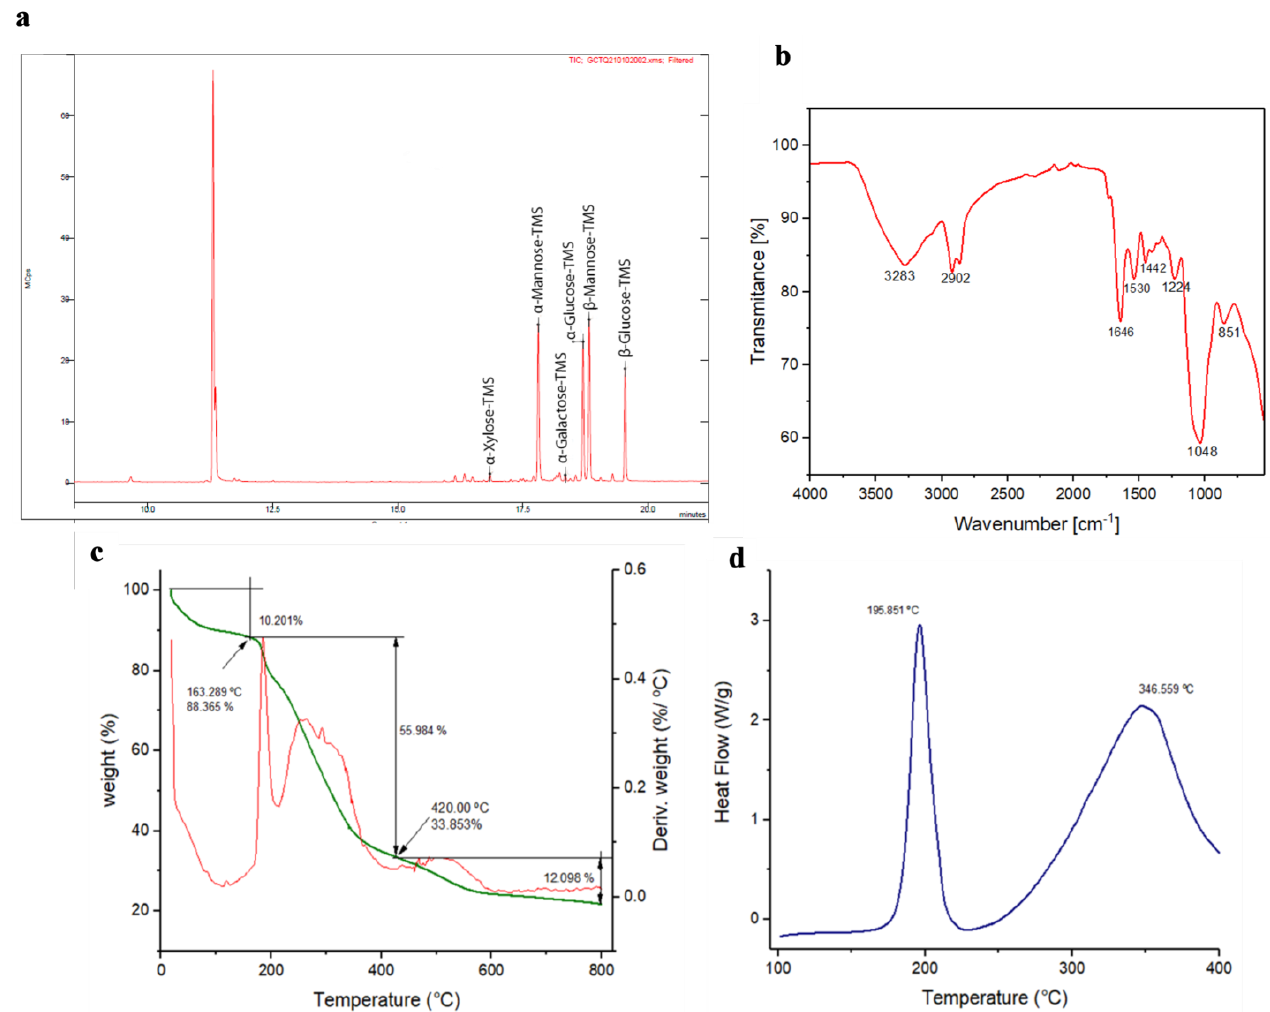
Figure 3. Characterisation analysis of EPS RT7 . ( a ) GC–MS; ( b ) ATR–FTIR spectra; ( c ) thermogravi- metric analysis (TGA); ( d ) differential scanning calorimetry